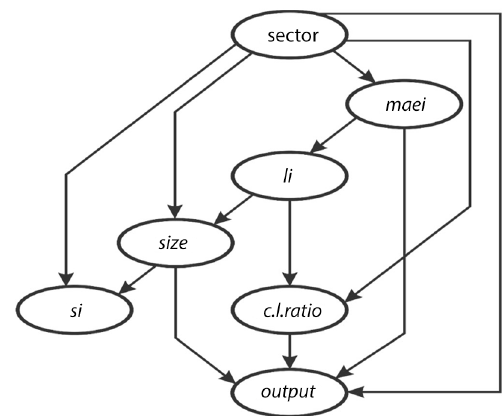
Figure 1. Resulting Bayesian